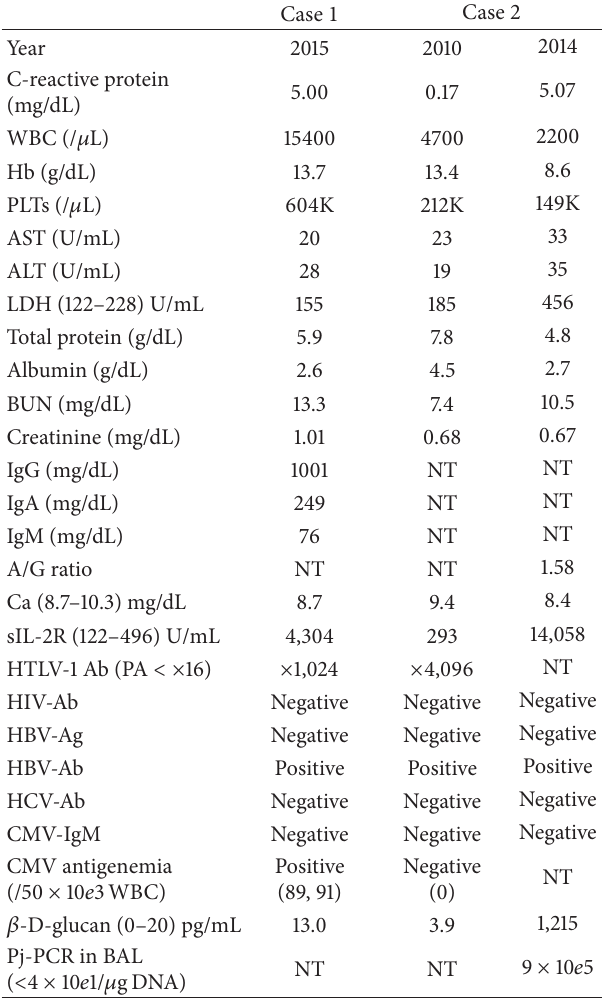
Table 1: Laboratory data of two